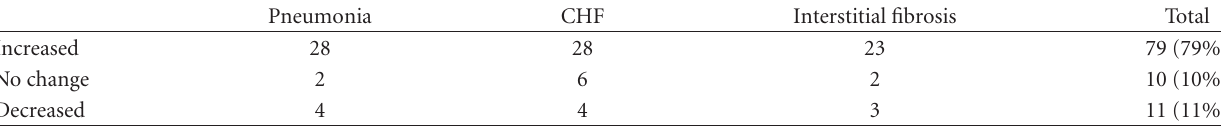
Table 1: Number of patients whose crackle pitch increased, decreased and did not change during inspiration.